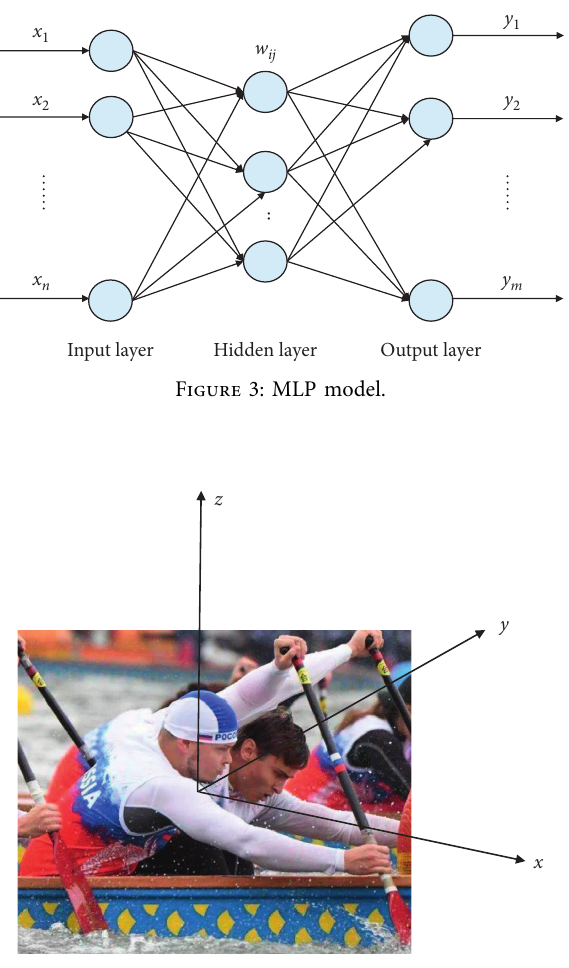
Figure 4: Movement